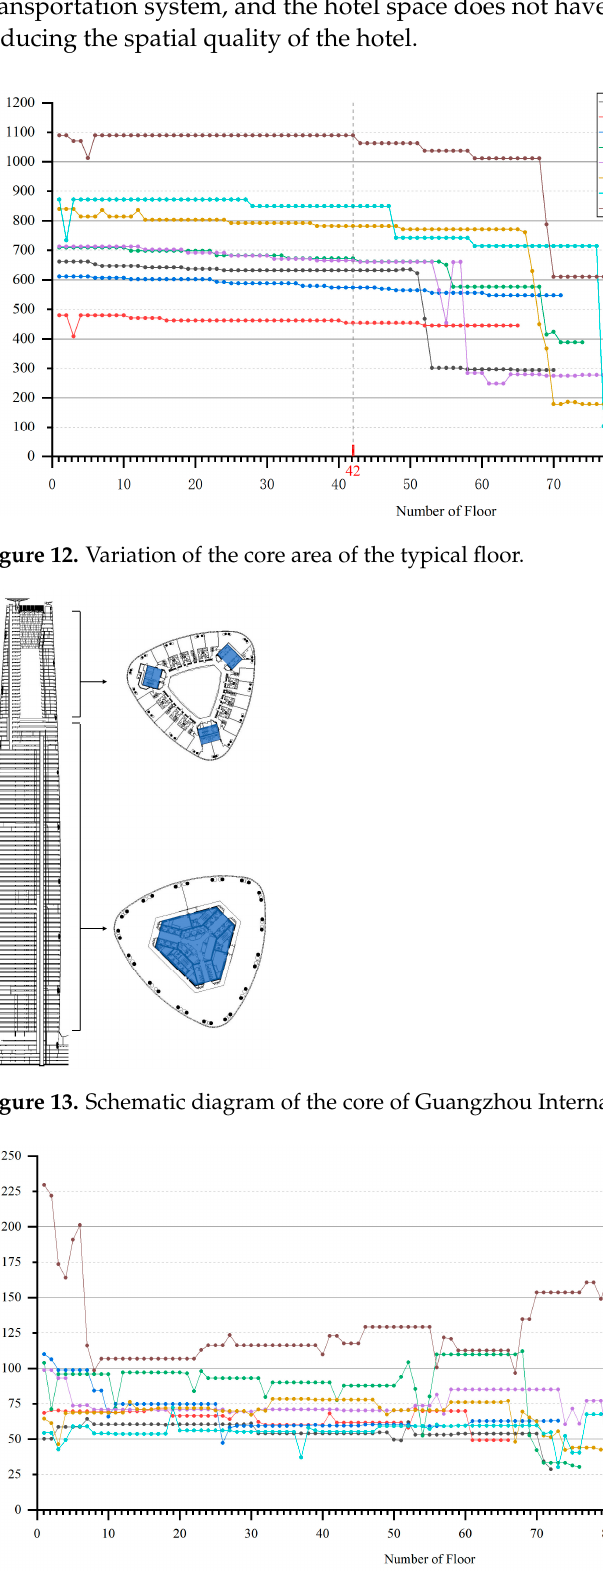
Figure 14. The total area of tube well equipment.